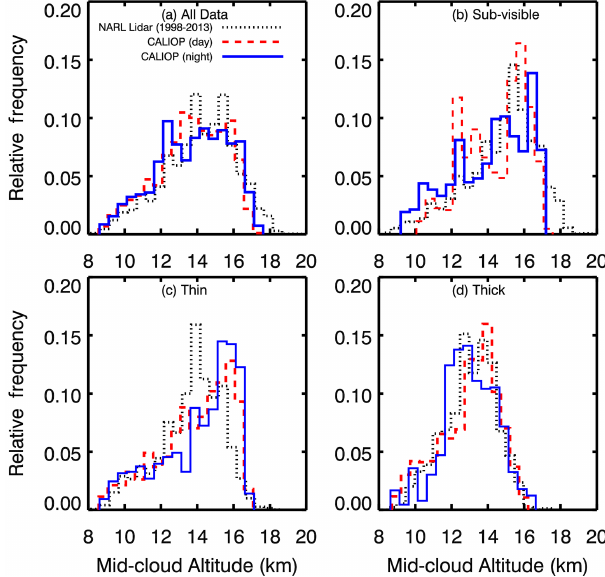
Figure 7. Histograms showing the frequency distribution of mid- cloud altitude in bins of 0.5km for (a) all cirrus cloud layers, (b) sub-visible cirrus ( τ <0.03), (c) thin cirrus (0.03< τ <0.3) and (d) thick cirrus cloud layers ( τ >0.3) obtained from NARL Li- dar (dotted black line), CALIOP daytime (dashed red line) and CALIOP night-time (solid blue line) data